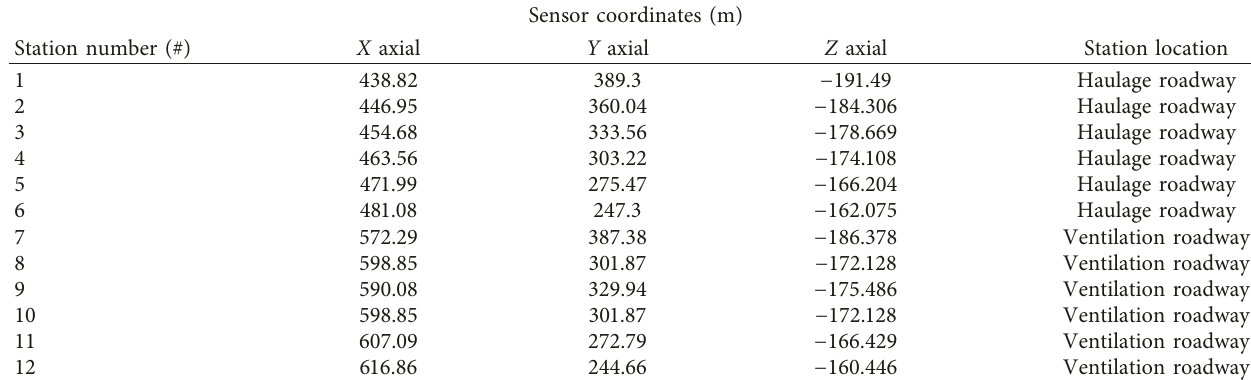
Figure 7: Comparison between the calculated value and true (theoretical) Table 1: Station layout parameters.